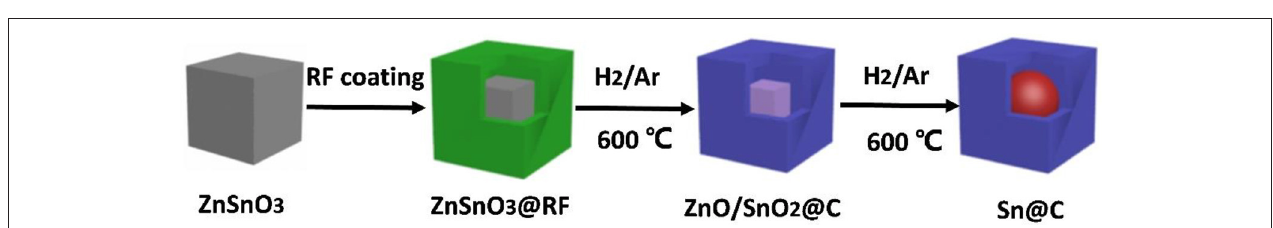
FIGURE 1 | Schematic diagram of the fabrication procedure of yolk-shell Sn@C nanobox.